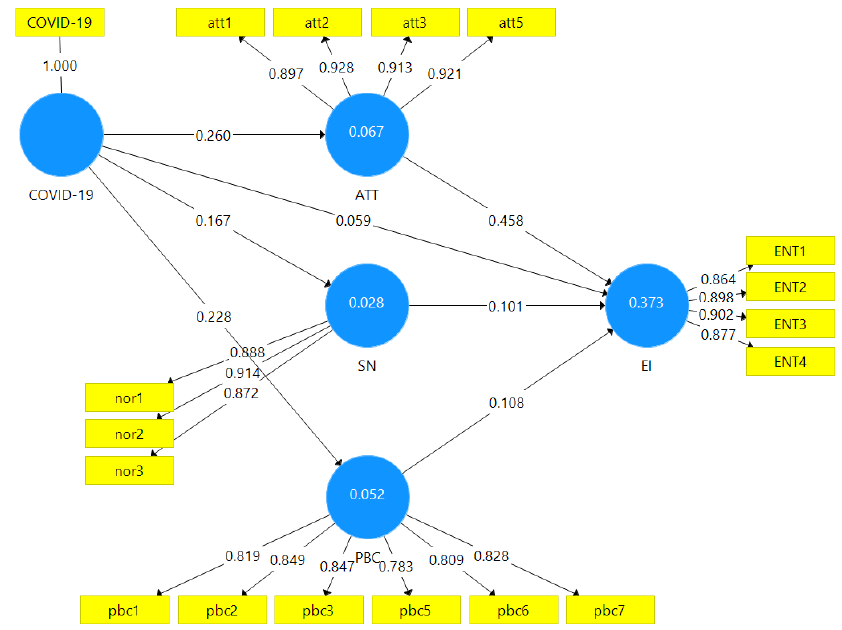
Figure 3. Measurement model. Note : ATT, attitude; EI, entrepreneurial intention; PBC, perceived